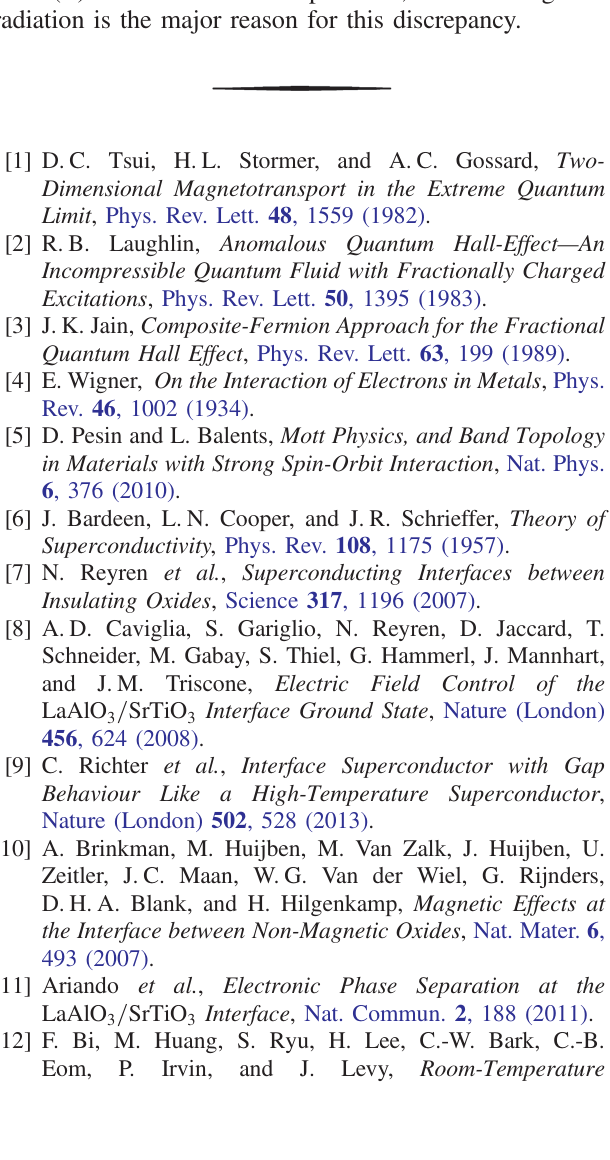
2 . 8 nA, R 40 . 4 k Ω , c ¼ J ¼